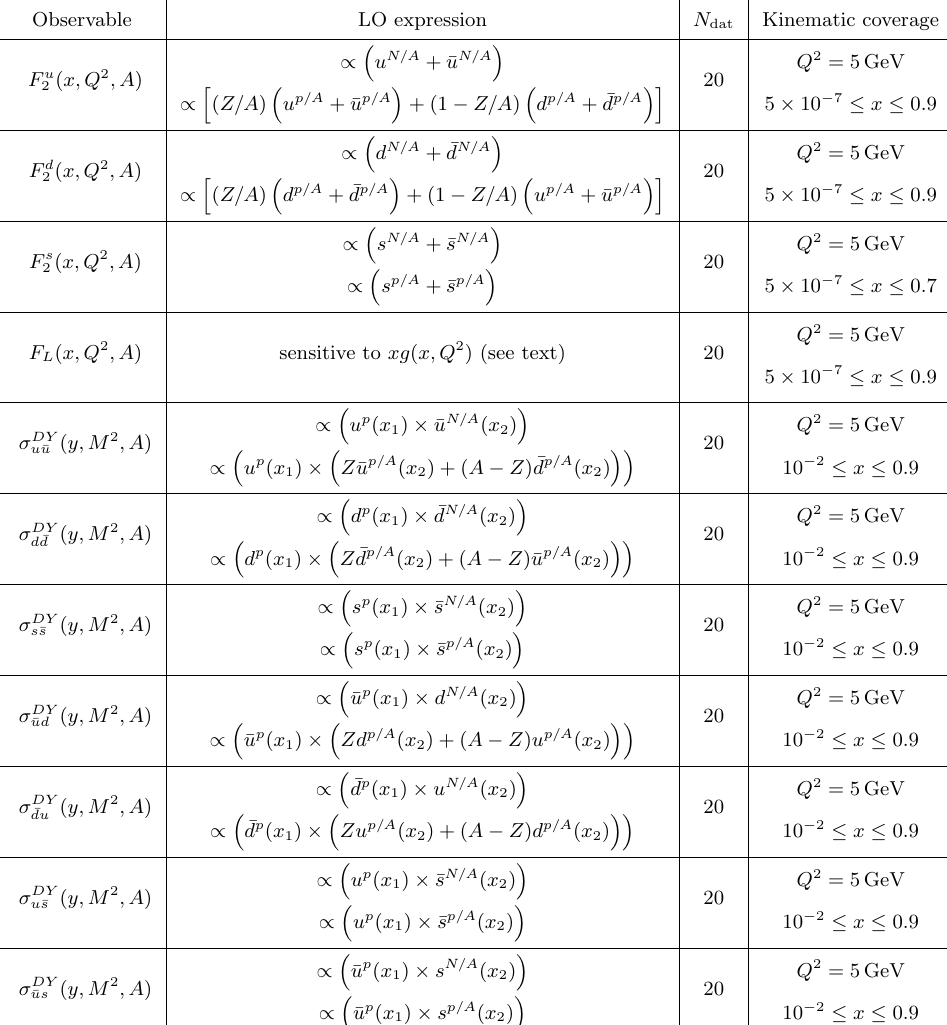
Table 3 . The processes used to impose the positivity of physical cross-sections by means of the constraint of eq. (3.18). For each process we indicate the corresponding LO expressions, the number of data points N dat , and the kinematic coverage spanned by the